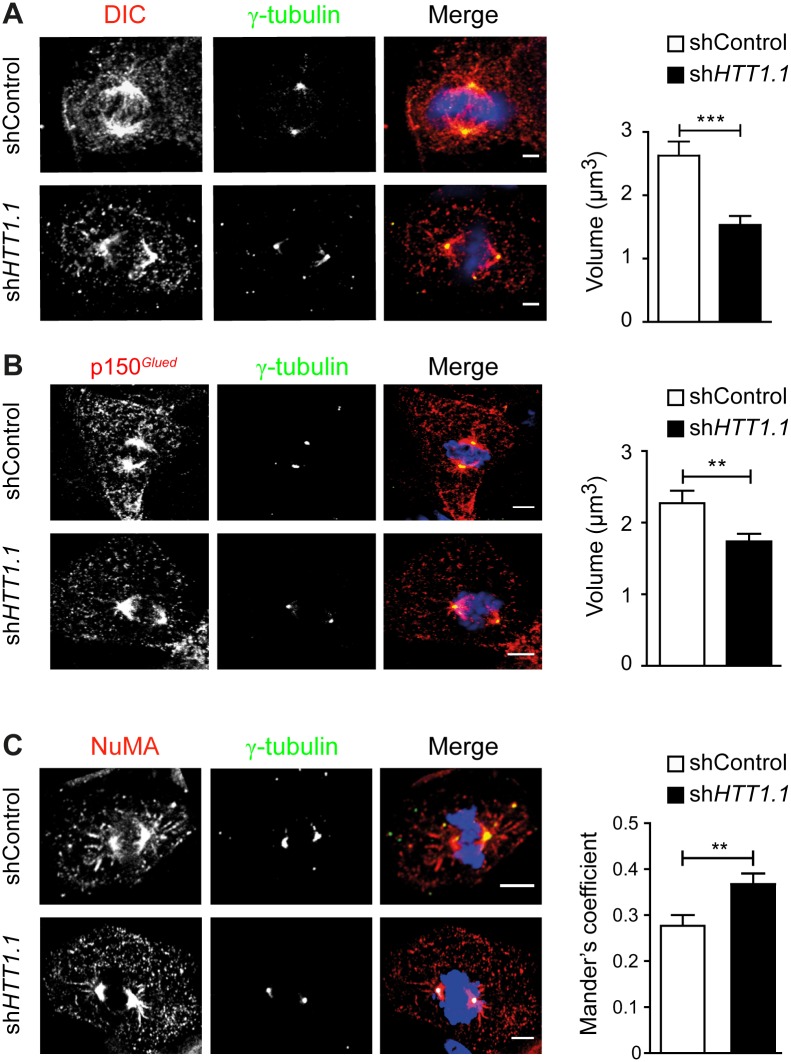
Loss of HTT alters dynein, p150Glued, and NuMA localization in human NSC.Immunostainings of metaphasic neural stem cells with anti-DIC (A), anti-p150Glued (B), anti-NUMA (C) and anti-γ-tubulin antibodies. Nuclei are counterstained with DAPI. Scale bars, 5 μm. Graphs correspond to the quantifications of (A): shControl: n = 52 and shHTT1.1: n = 60; (B): shControl: n = 57 and shHTT1.1: n = 60; (C): shControl: n = 22 and shHTT1.1: n = 22 cells analysed in at least 3 independent experiments. Results are shown as mean values ± SEM. ***p<0.001; **p<0.01; Student’s t-test.